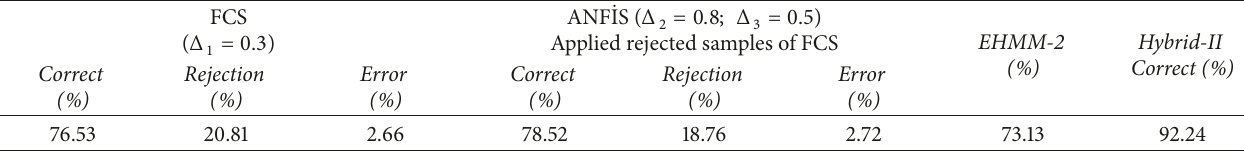
Table 6: Average 10-fold CV results of